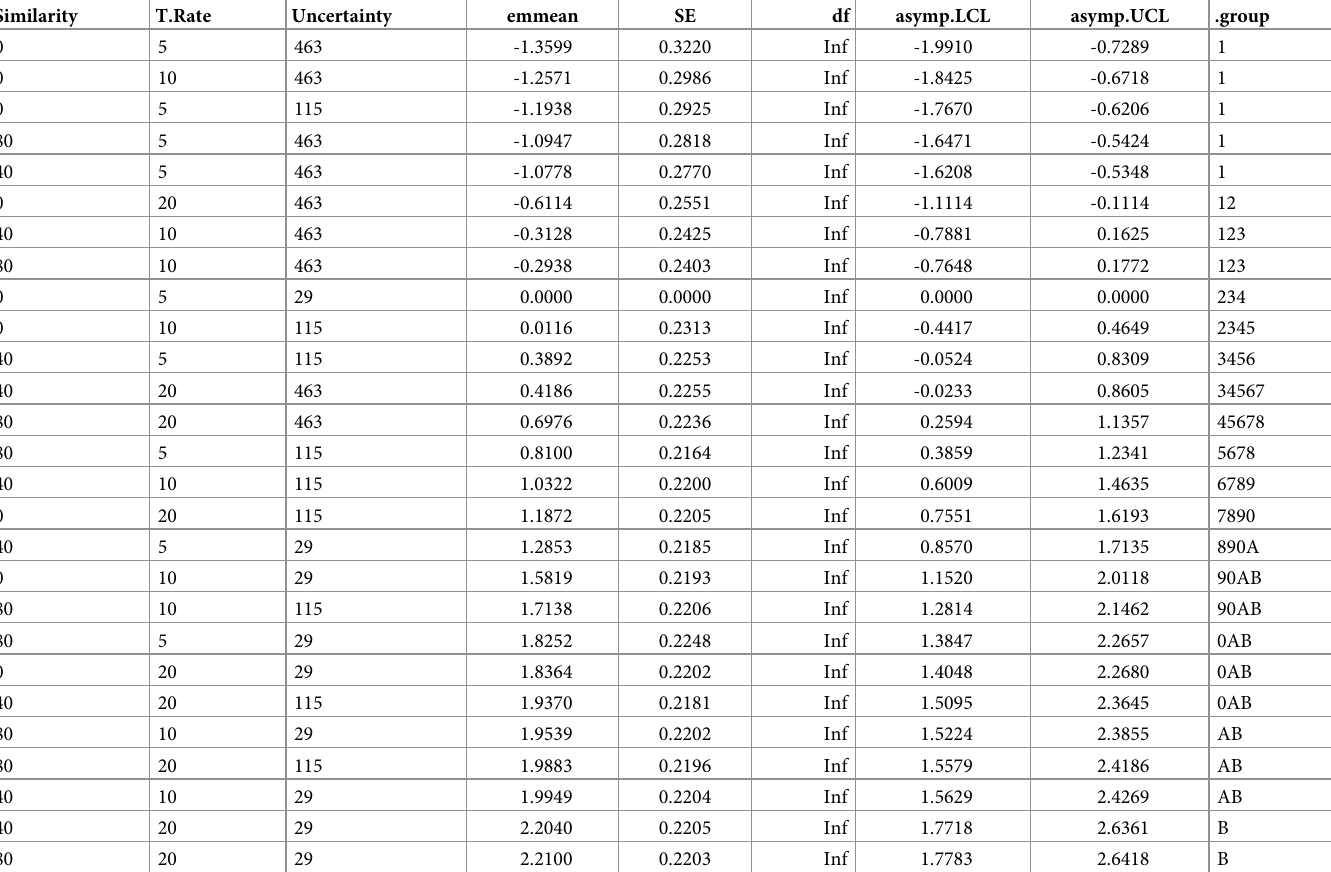
Table 5. Estimated marginal means and compact letter display for all-pairwise comparisons of the interaction between masker-target similarity and masker uncer- tainty in Experiment II.